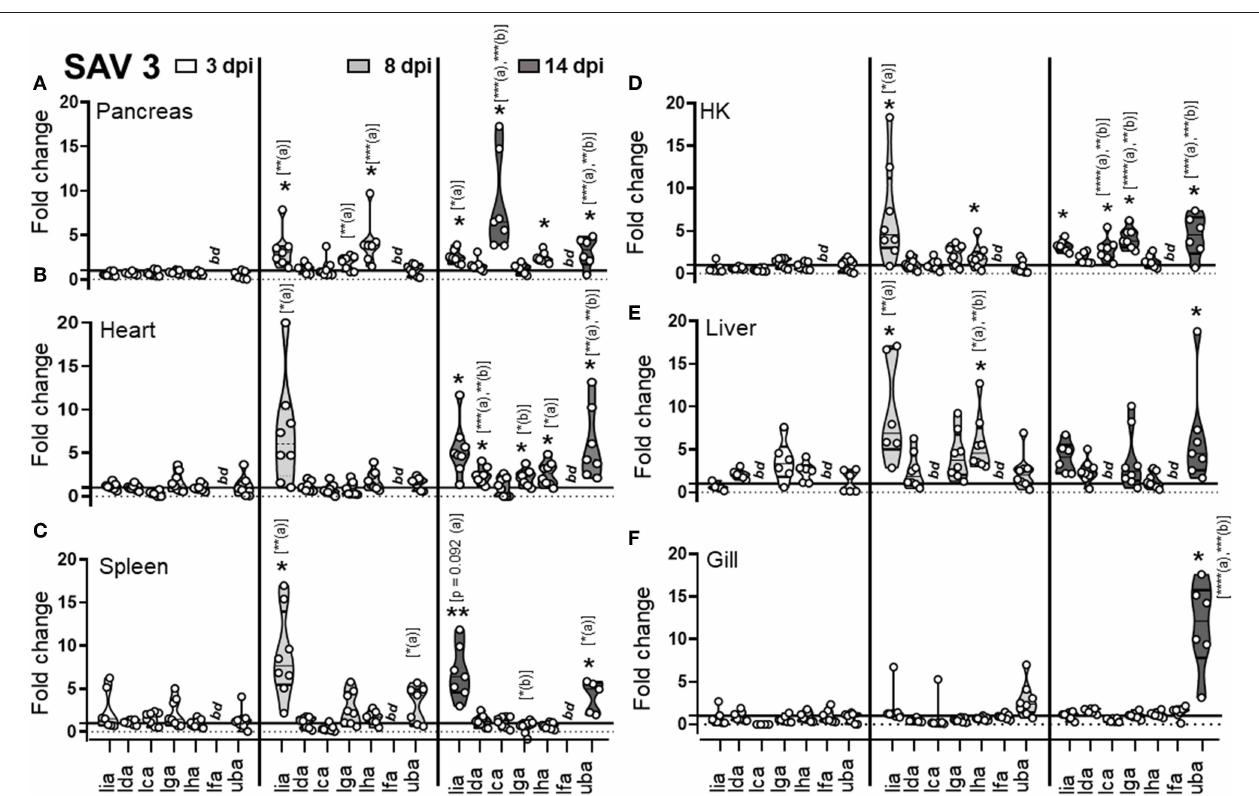
FIGURE 2 | Expression of MHC class I L lineage genes in different tissues of Atlantic salmon following i.p SAV3 challenge. Pre-smolt Atlantic salmon were intra peritoneal (i.p) injected with 100 µ l SAV3 (1 × 10 5 TCID 50 ) or PBS and samples were collected at 3 (white), 8 (light gray), and 14 days (dark gray) post infection. (A–F) Fold change in the expression of L lineage MHC class I genes ( lia, lda, lca, lga, lha, and lfa ) and classical MHC class I ( uba ) in different tissues at various times post challenge ( n ǫ 8), relative to the control groups from the same time point ( n ǫ 4). Each dot represents an individual fish, and the line intersecting the y-axis at 1 represents the unstimulated control that the fold change of the treatments is in relation to. Asterisks above each violin plot indicates the strength of significance compared to PBS injected controls, and letters above each violin represent statistical differences among the different time points for each individual gene ( a = 3 dpi; b = 8 dpi, and c = 14 dpi), * p < 0.05, ** p < 0.01, *** p = 0.0001, **** p < 0.0001, bd , below